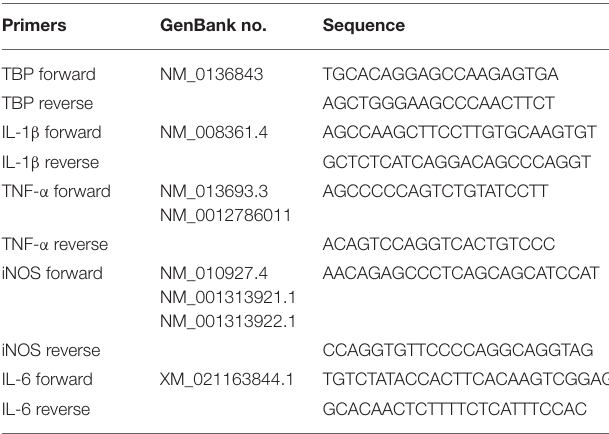
TABLE 1 | Primers used for the quantitative real-time PCR.